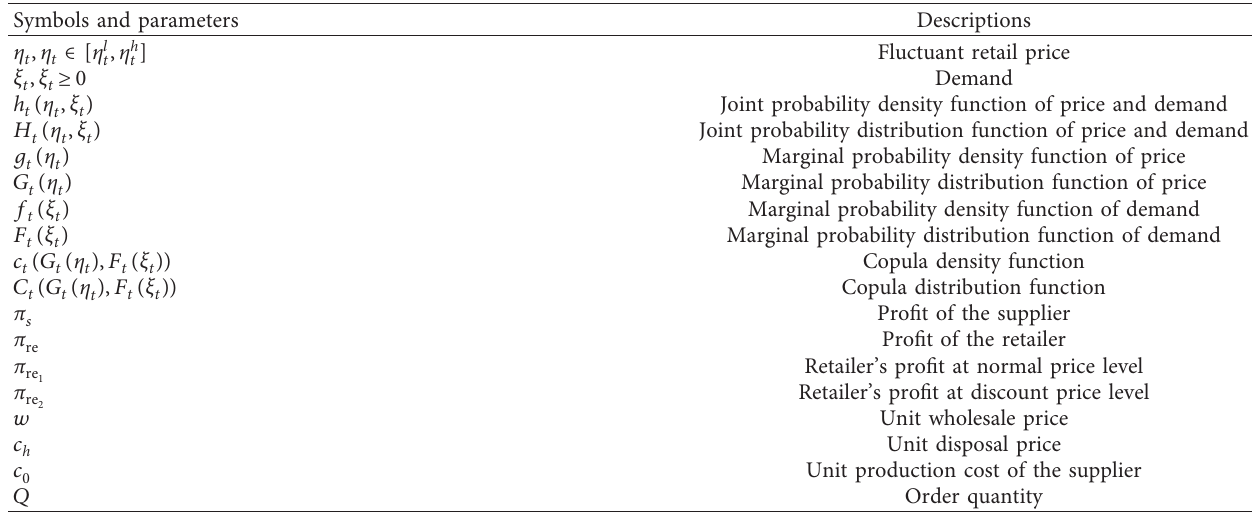
Figure 1: Illustration of two-level price-fluctuation sales: (a) Case 1: no overlap between the two ranges; (b) Case 2: some overlap between the two Table 2: Descriptions of symbols and parameters ( t � 1, 2).